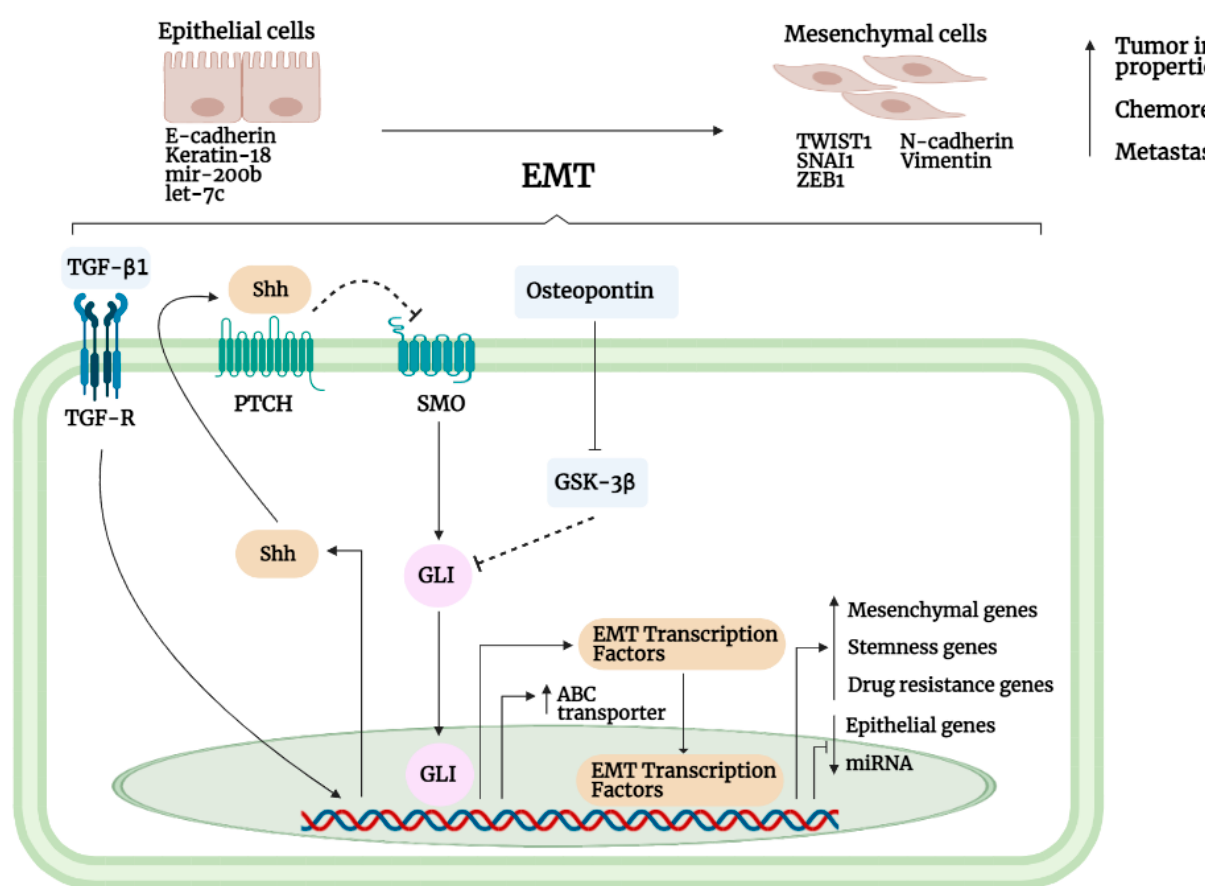
Figure 5. A schematic representation of canonical and noncanonical GLI regulation in promoting EMT and chemoresistance. TGF- β 1 stimulation induced the transcriptional upregulation of Shh, which activates canonical Hh-GLI signaling in an autocrine manner. On the other hand, OPN inactivates GSK3 β , promoting the activation of GLI independent of canonical input. Activated GLI translocates into the nucleus, where it upregulates the expression of EMT transcription factors (e.g., TWIST1 , SNAI1 , ZEB1 ). In turn, upregulated EMT transcription factors induce the expression of mesenchymal (e.g., N-cadherin , Vimentin ), stemness (e.g., SOX2 , OCT4 , ALDH ), and drug resistance genes (e.g., ALDH , ABC transporters) while concomitantly downregulating epithelial ( E-cadherin ) genes and miRNAs (mir-200b and let-7 family). Consequently, this results in the formation of mesenchymal cells with tumor-initiating-like properties and the increased capability to metastasize and resist cytotoxic chemotherapeutics. Additionally, increased GLI1 activity also upregulates ABC transporters, further enhancing chemoresistance by increasing drug efflux in mesenchymal